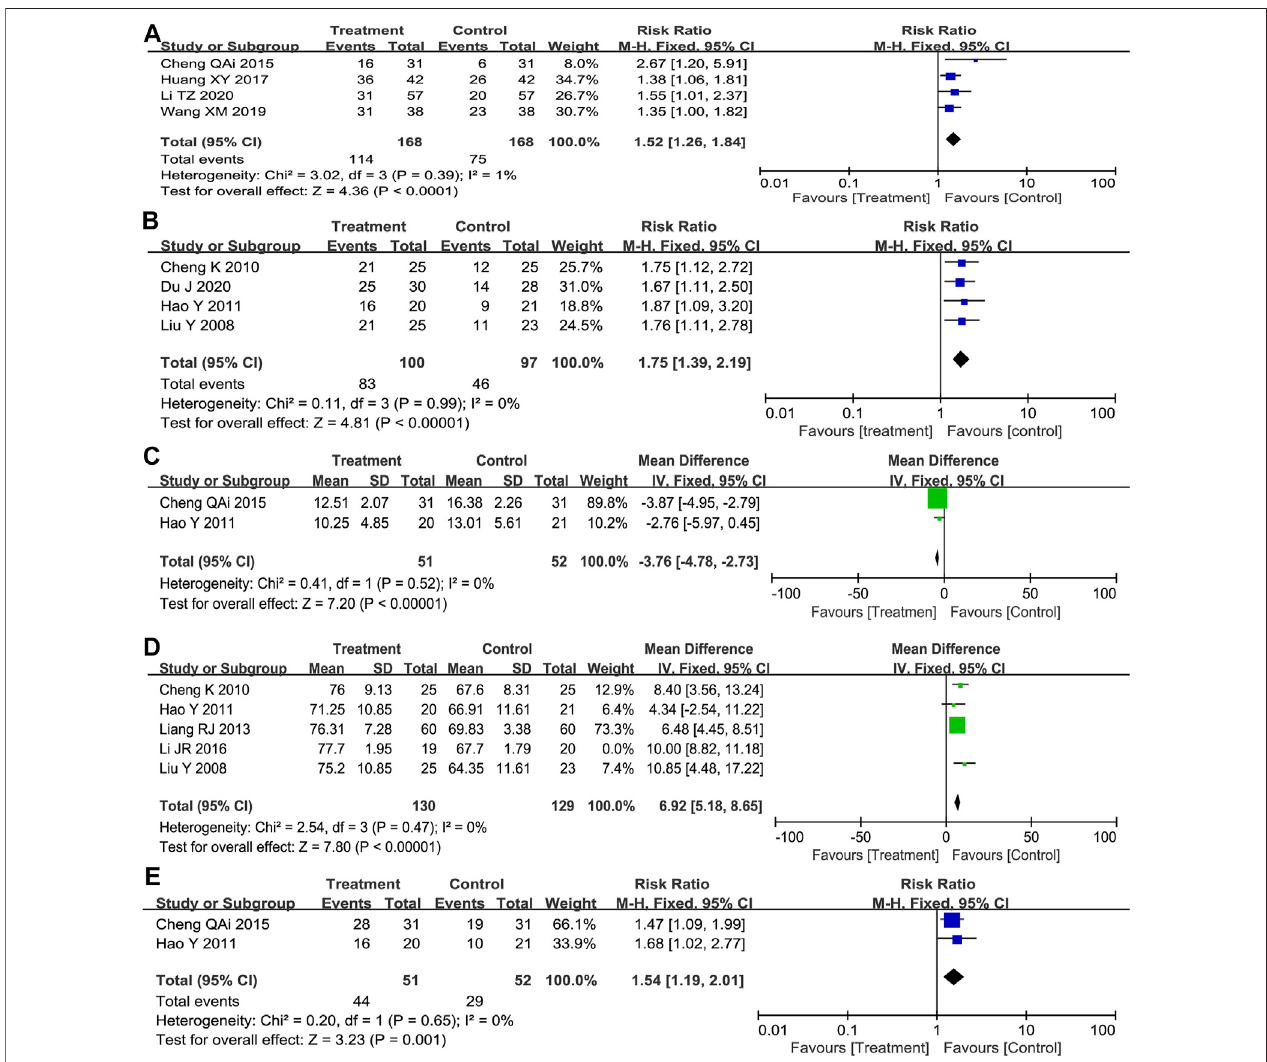
FIGURE 2 | Forest plot displayed the results of the meta-analysis. (A) TRR. (B) TCM syndrome score for dichotomous outcomes. (C) TCM syndrome score for continuous scales. (D) KPS for continuous scales. (E) KPS for dichotomous outcomes. KPS, Karnofsky Performance Scale.